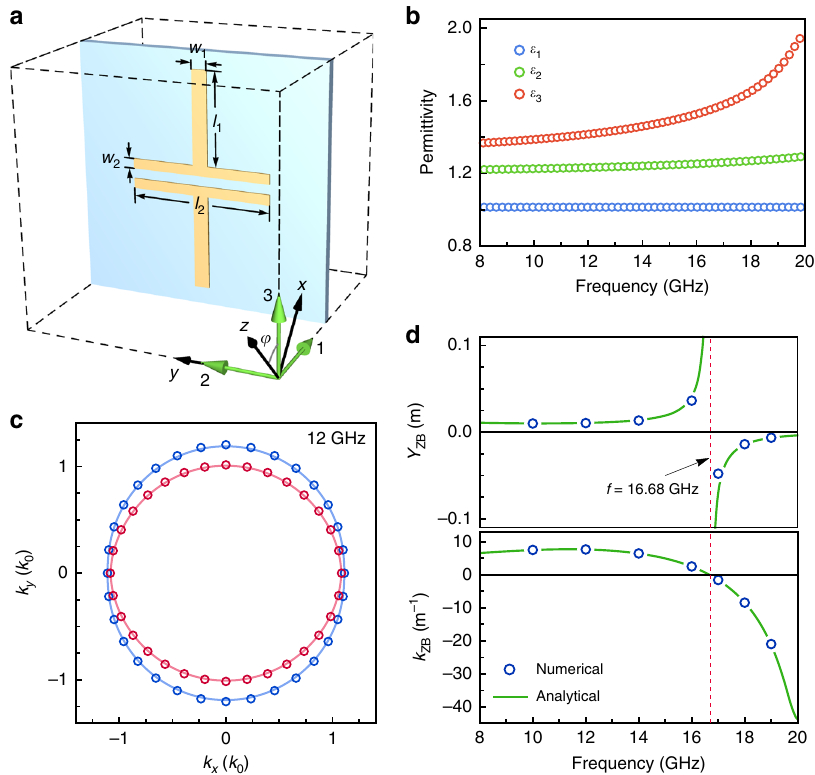
Fig. 2 Design of a biaxial metamaterial. a Unit cell of the simple cubic structure with lattice constants d = 5 mm, where a FR4 PCB slab (light blue) with thickness 0.2 mm and relative permittivity ε 3 : 3 fi lls the coronal plane, and a copper structure of thickness 0.035 mm is printed on the PCB slab with pcb ¼ the geometric parameters l 1 = 2 mm, l 2 = 2.8 mm, w 1 = 0.3 mm, and w 2 = 0.2 mm. b Dispersions of the retrieved relative permittivities along the three principal axes. c Isofrequency contours of the metamaterial in the xy -plane at 12 GHz, where the circular markers and solid curves correspond, respectively, to the real structure in a and the retrieved homogeneous medium. d Full-wave simulated (blue circles) and analytical (green curves) ZB amplitude Y ZB and ZB wave number k ZB in the homogenized media varying with